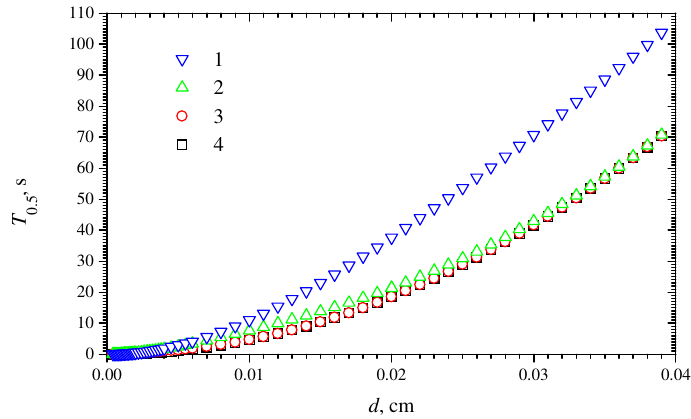
Figure 3 . The dependence of the half time T 0.5 of the maximal biosensor current on the membrane thickness d at four maximal enzymatic rates V